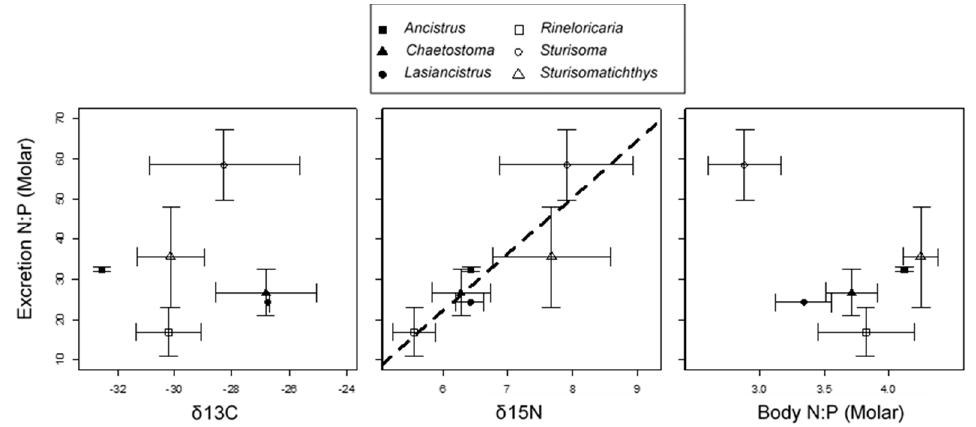
Figure 4. Relationships between excretion N:P and δ 13 C, δ 15 N, and body N:P among species of Panamanian loricariids. Excretion N:P was positively correlated with δ 15 N (r = 0.884, p = 0.019), but not δ 13 C or body N:P. Dark symbols are genera in Hypostominae, and white symbols are genera in Loricariinae. Error bars represent standard deviation.